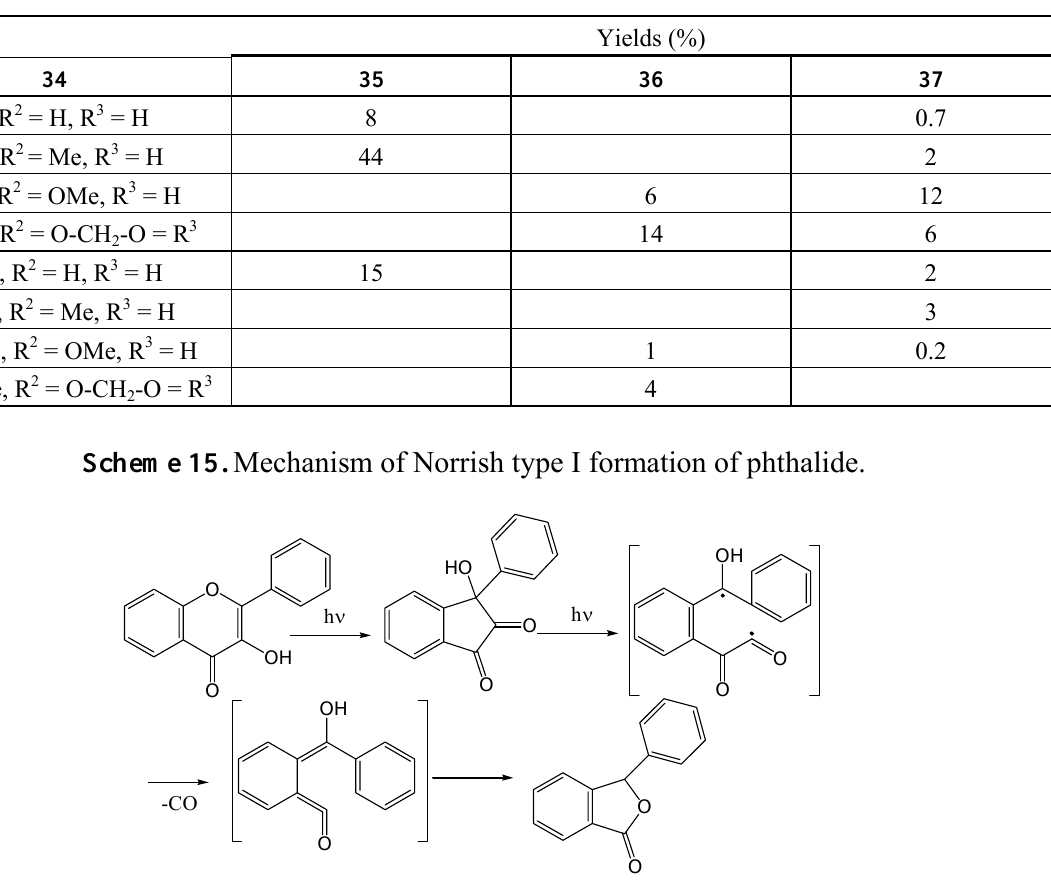
Table 3. Products obtained by the irradiation of flavonol in methanol.